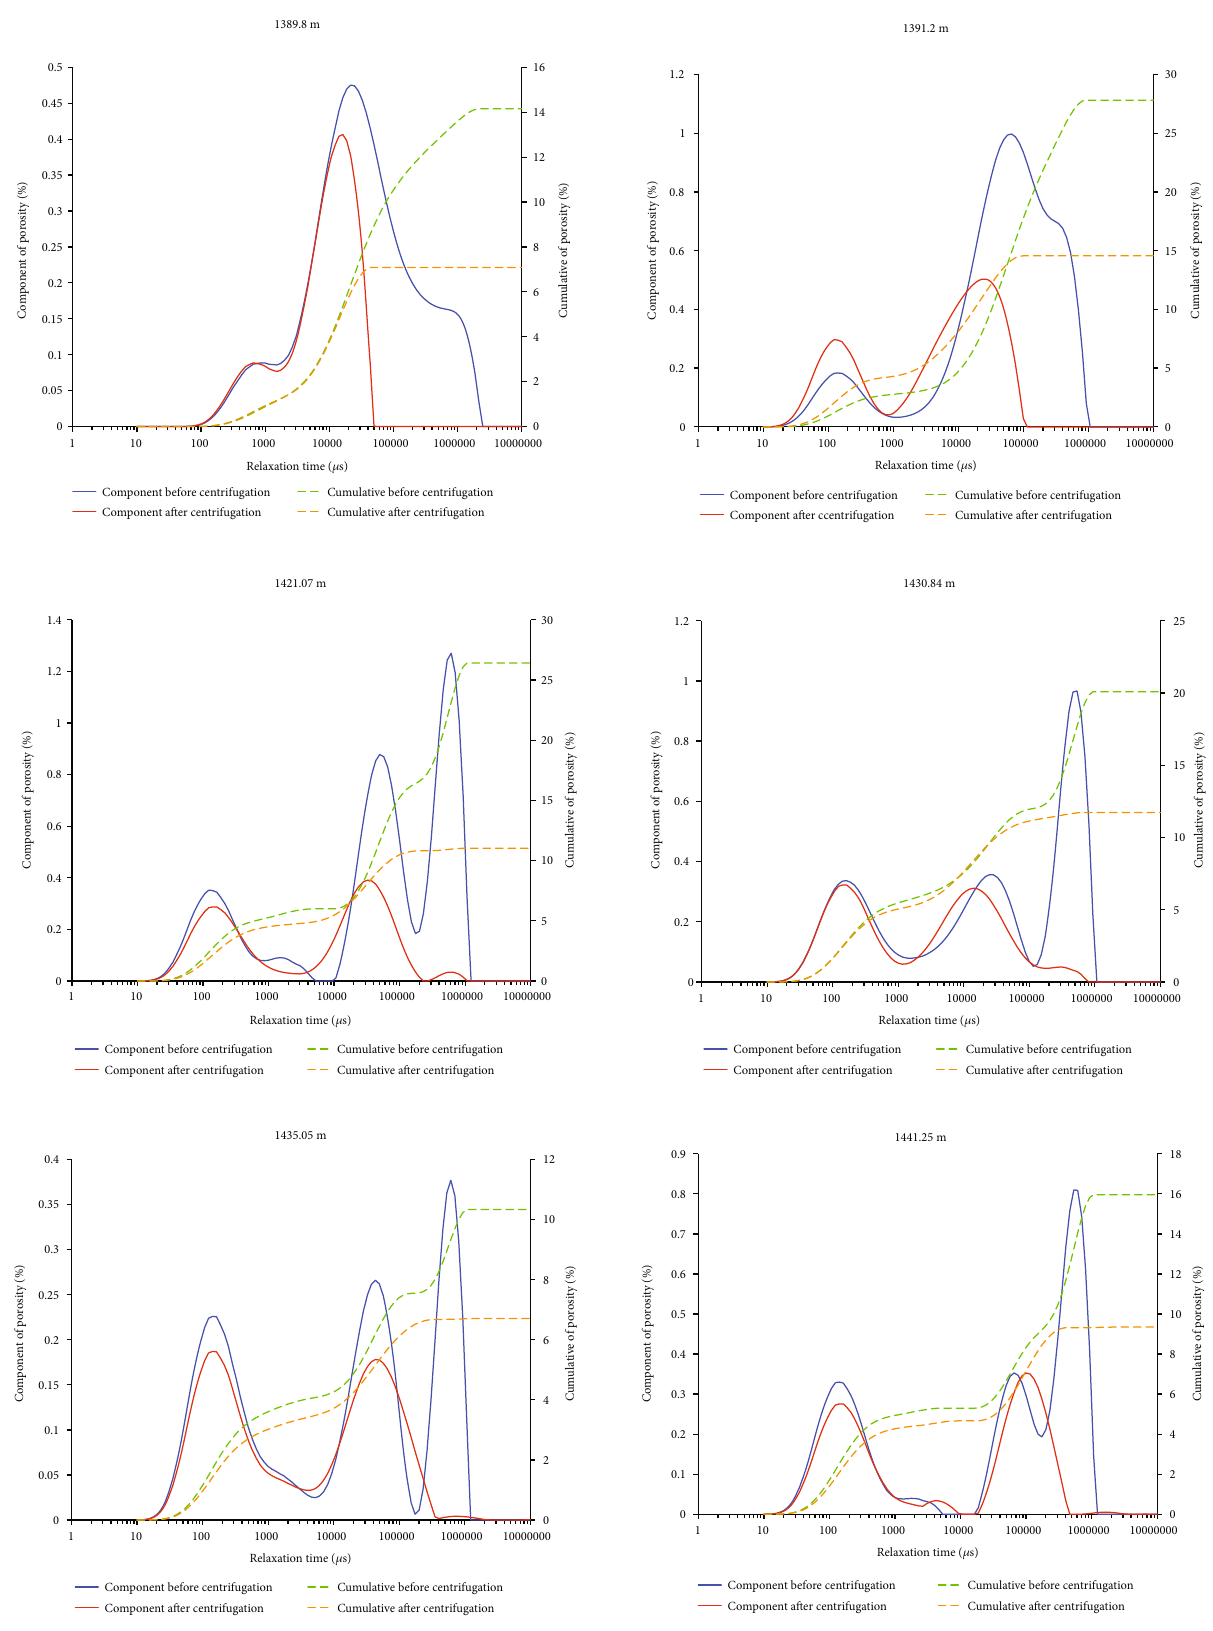
Figure 8: NMR T spectrum of cores in well DF51 at di ff erent 2